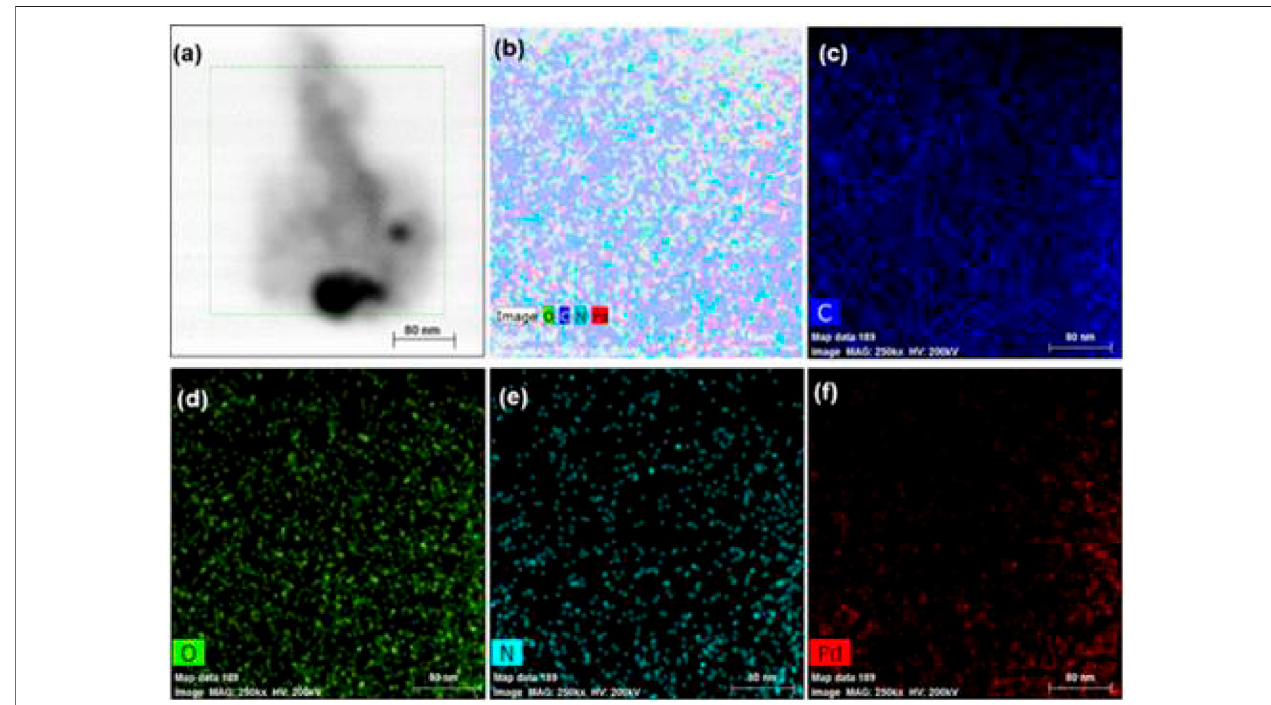
FIGURE 8 | (A) TEM images of Pd@CD-CONH, (B) EDAX mapping of some areas of the catalyst, (C) C, (D) O, (E) N, and (F) Pd. (Reproduced from Selim et al., 2020, American Chemical